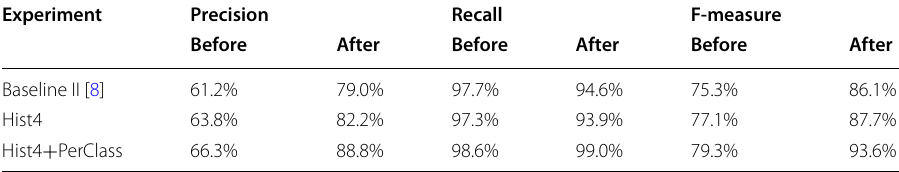
Table 11 The results before and after the dataset re-annotation Experiment Precision Recall F‑measure Before After Before After Before After Baseline II [8] 61.2% 79.0% 97.7% 94.6% 75.3% 86.1% Hist4 63.8% 82.2% 97.3% 93.9% 77.1% 87.7% Hist4 PerClass 66.3% 88.8% 98.6% +